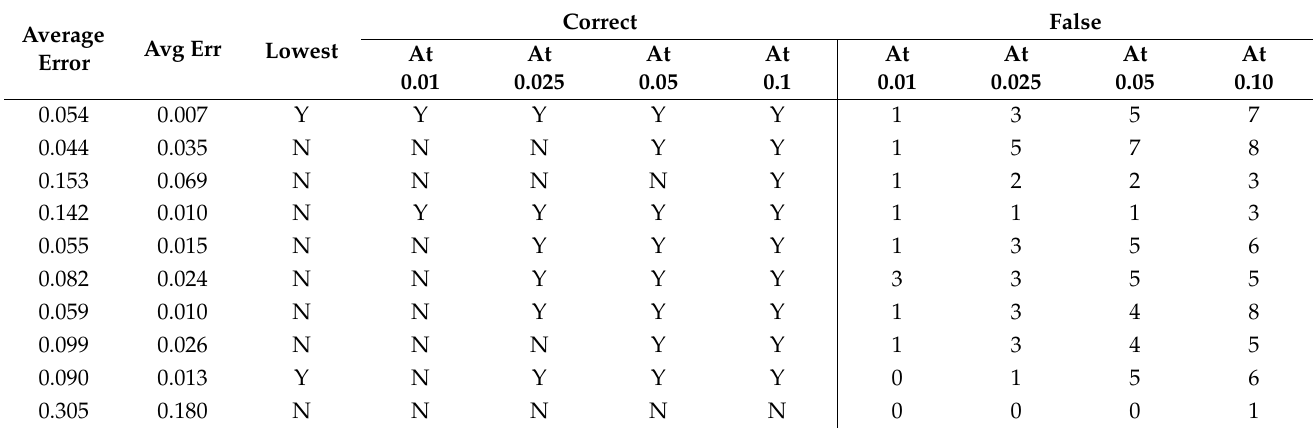
Table A14. Set 1, trials 1–10 summary data (actual PR value).